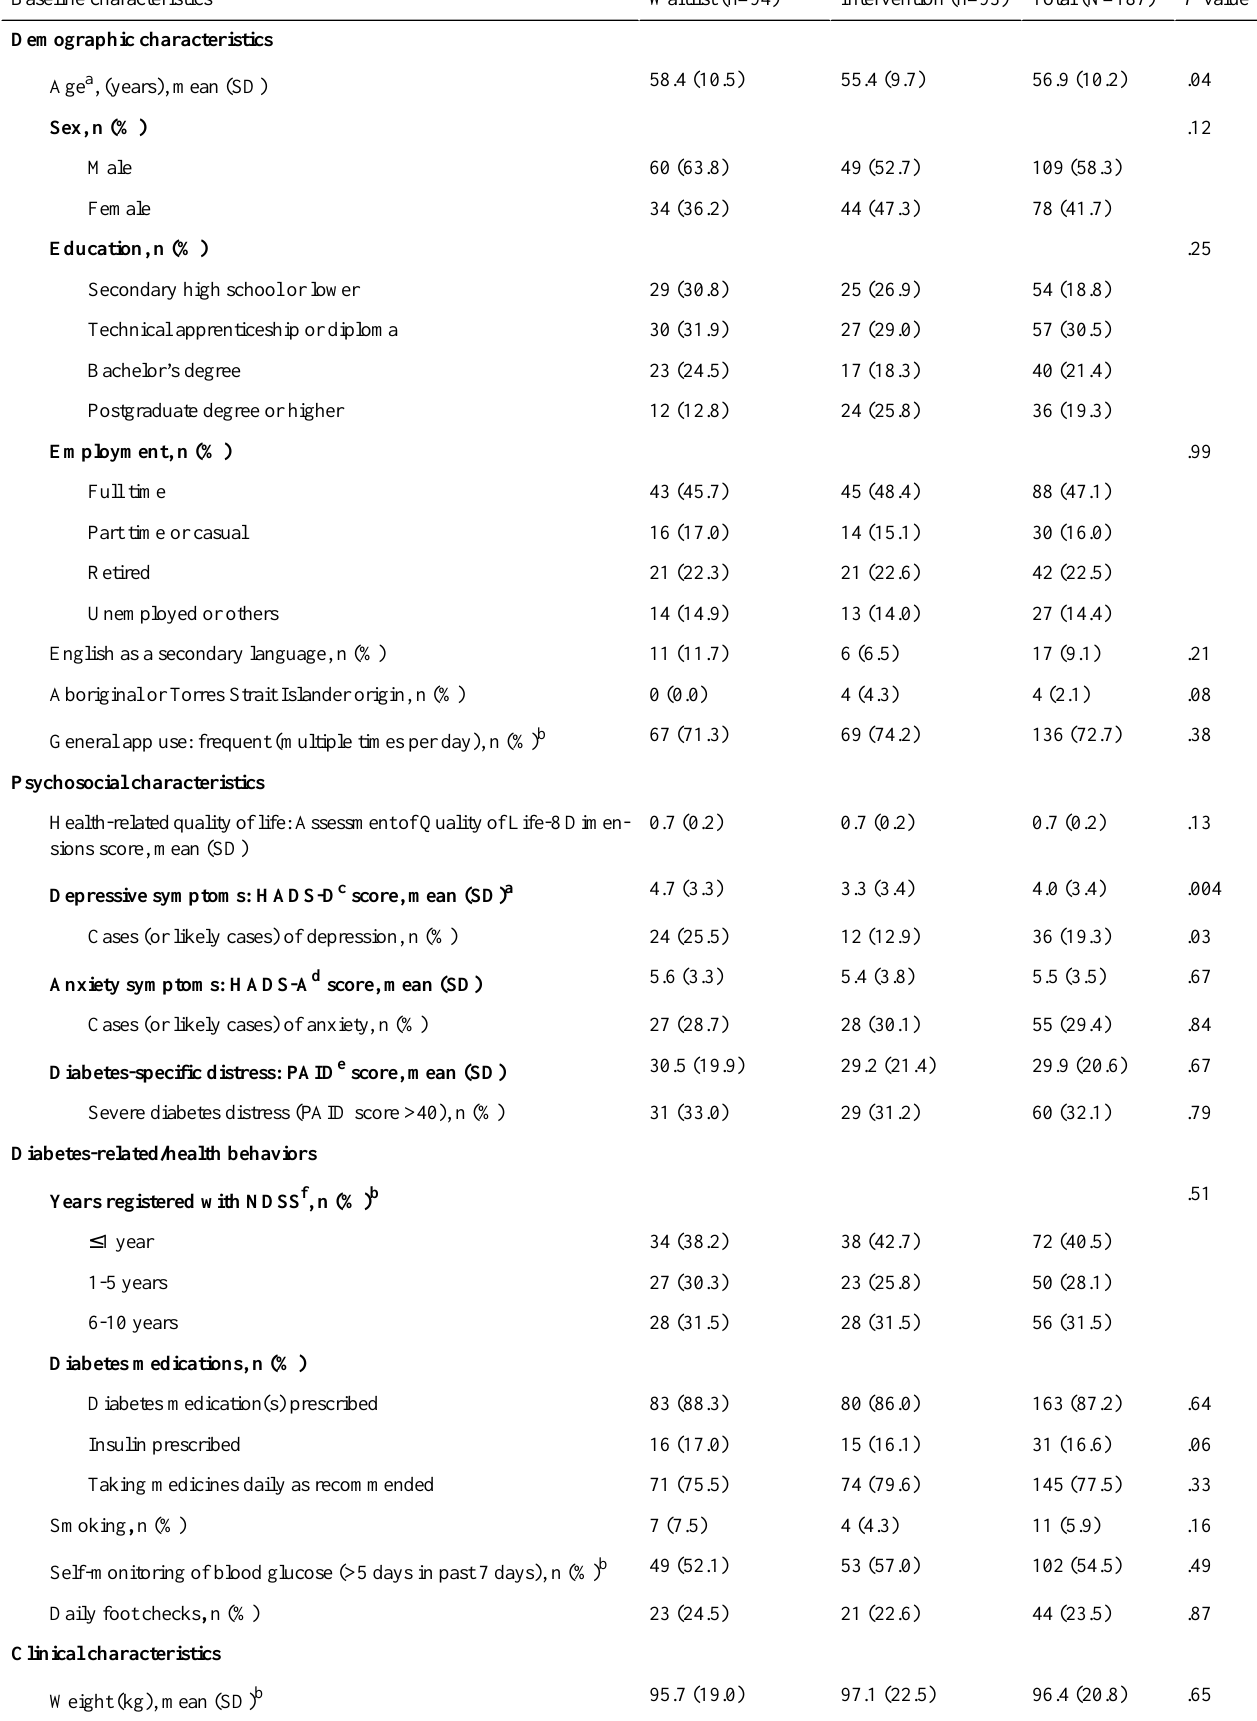
Table 1. Baseline characteristics of study